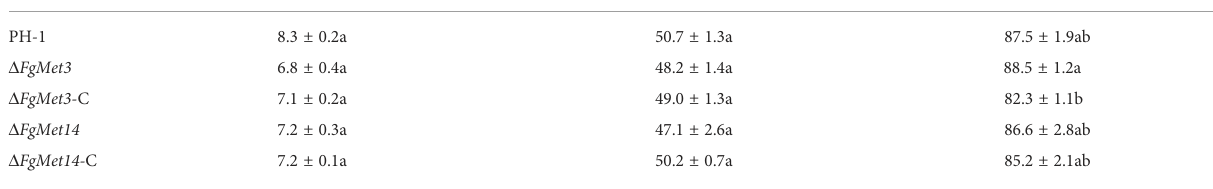
TABLE 1 Sporulation quantity and conidia germination of PH-1, FgMet3 or FgMet14 deletion mutants and their complements. Strain